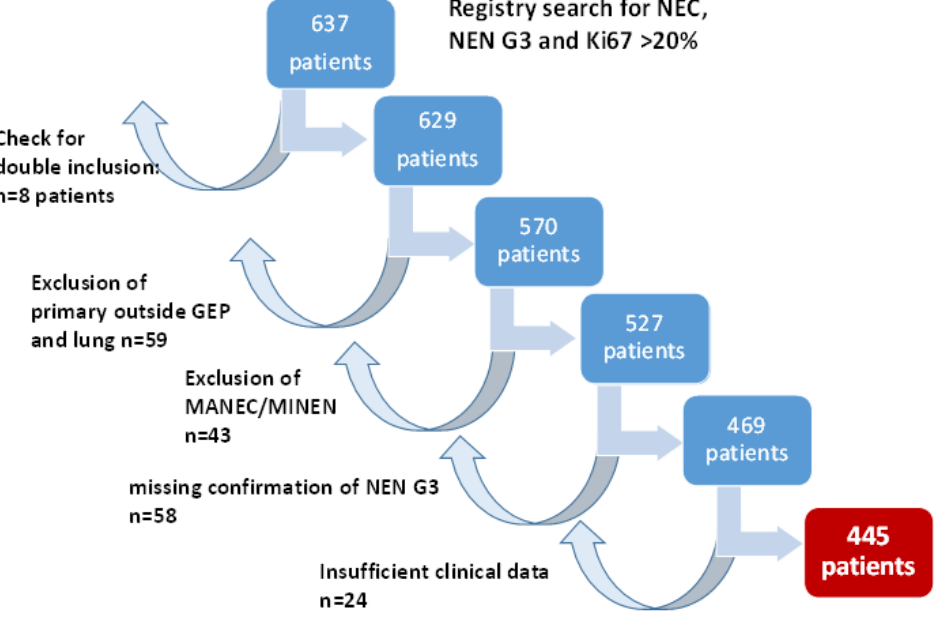
Figure 1. Patient selection for this trial. GEP: gastroenteropancreatic; MANEC: mixed adeno-neuroendocrine carcinoma; MiNEN: mixed neuroendocrine/non-neuroendocrine neoplasms. The median age at diagnosis of the 246 male (55.3%) and 199 female (44.7%) patients was 63 years. More than 60% of patients had a good performance status (ECOG 0 and 1) at diagnosis, and 26.6% initially presented without distant metastases. Only a minority of 26 patients (5.8%) had functioning tumors (including carcinoid syndrome, insulinoma, gastrinoma, glucagonoma and VIPoma). The most common primary sites were the pancreas (29.7%), unknown (CUP 21.8%), and the colon and rectum (19.1%). The most common metastatic sites were the liver (67.4%), lymph nodes (55.3%) and bone (21.3%). At first diagnosis, histology was NET G1/2 in 11.9% of cases, progressing to NEN G3 during the course of the disease. Overall, tumors were classified as NET in 31.7% and NEC in 60%, and morphological classification was missing in 8.3%. Median Ki67 was 50%. In 49 patients (11.1%), second malignancies were documented; the most common were prostate cancer ( n = 7), skin tumors ( n = 6) and breast cancer ( n = 5). Patient characteristics are summarized in Table 1. Table 1. Patient